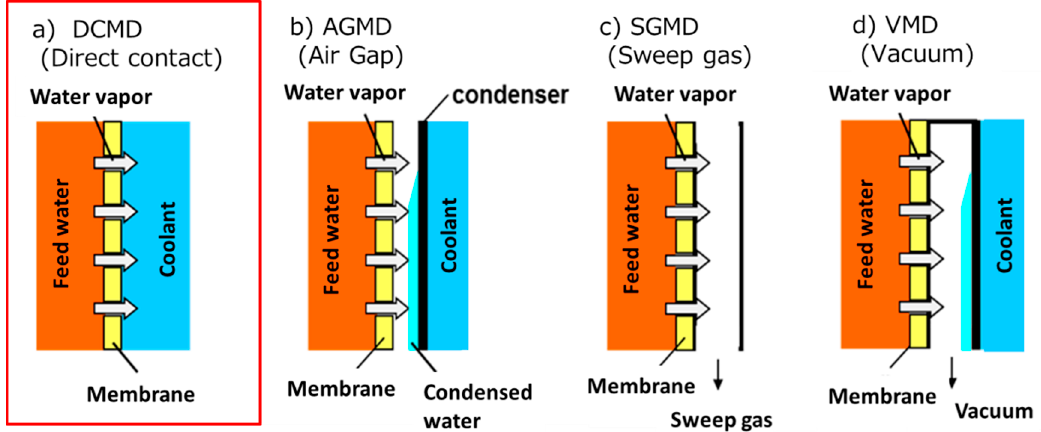
Figure 1. Schematics of typical membrane distillation (MD) operation setups. ( a ) Direct contact MD (DCMD), ( b ) Air gap MD (AGMD), ( c ) Sweep gas MD (SGMD), ( d ) Vacuum MD (VMD). DCMD was used in this paper.